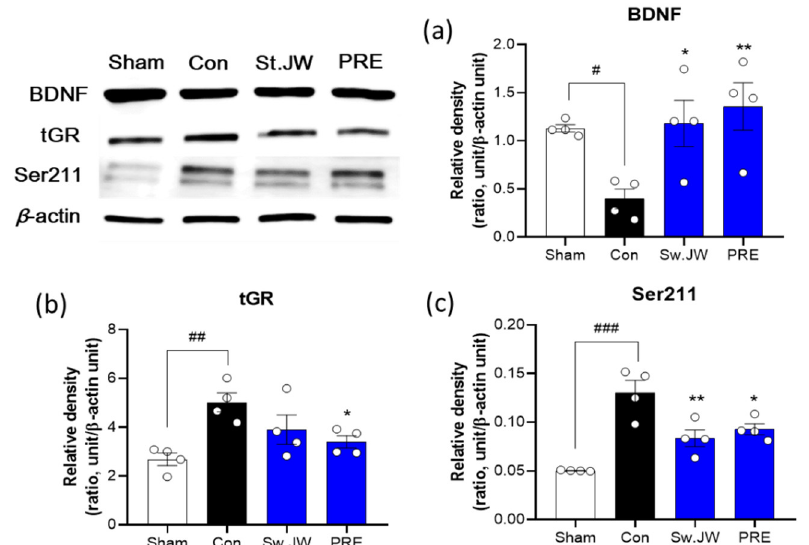
Figure 5. Effect of PRE on glucocorticoid receptor activity in CORT-induced depressive mice. Hip- pocampal Western blot analysis revealed that CORT injections significantly decreased BDNF ( a ) ex- pression and increased tGR ( b ) and Ser211 ( c ) expression in the hippocampus, while treatment with PRE at 300 mg/kg significantly attenuated the effect. Results are presented as mean ± SEM ( n = 4, per group). # p < 0.05, ## p < 0.01, and ### p < 0.001 versus the sham group; * p < 0.05, and ** p < 0.01 versus the CORT-injected Con group. Con, control; CORT, corticosterone; St. JW, St. John’s wort extract; PRE, P. resupinata extract.